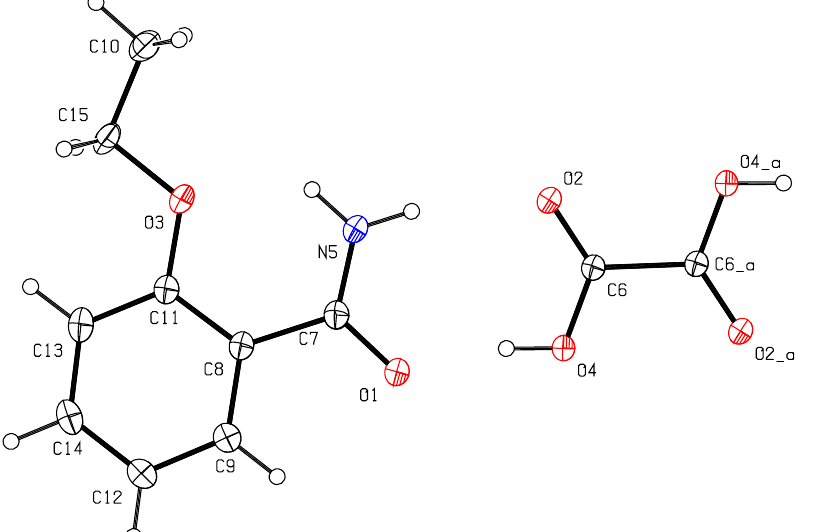
Table  : Data collection and